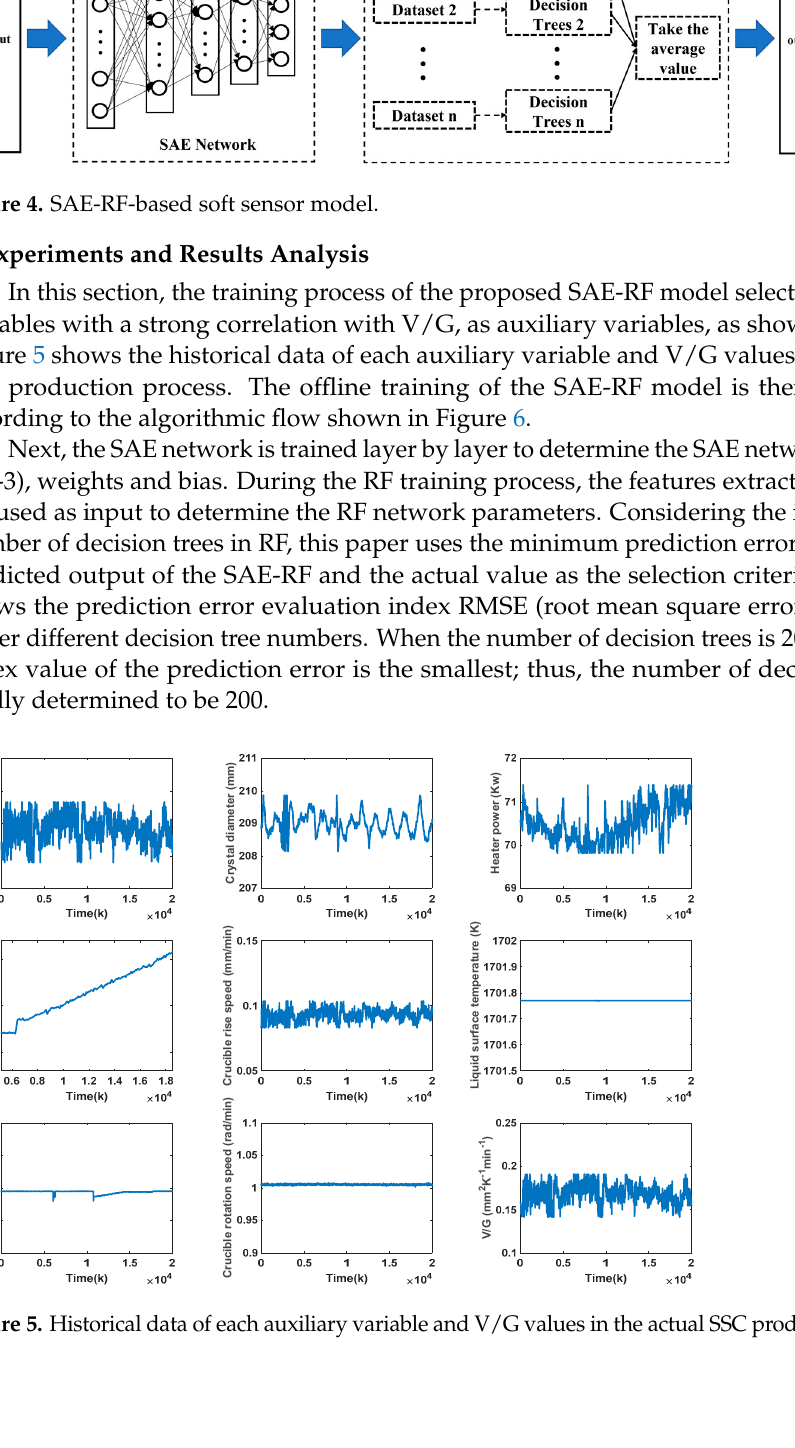
Figure 5. Historical data of each auxiliary variable and V/G values in the actual SSC production process.